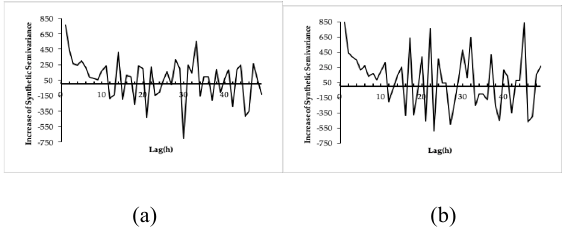
Figure 7. Computed results of the increase of the synthetic